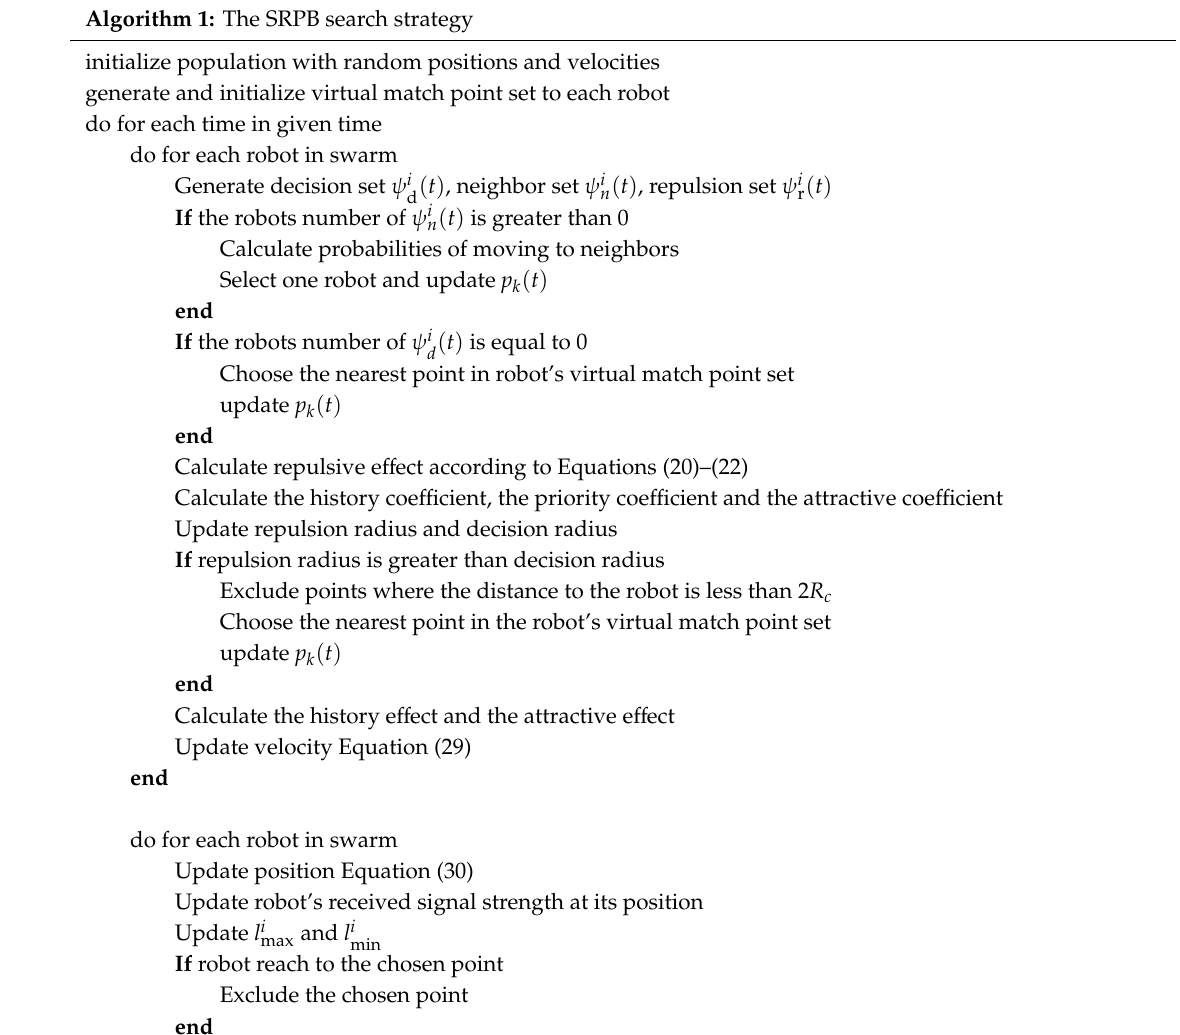
Algorithm 1: The SRPB search